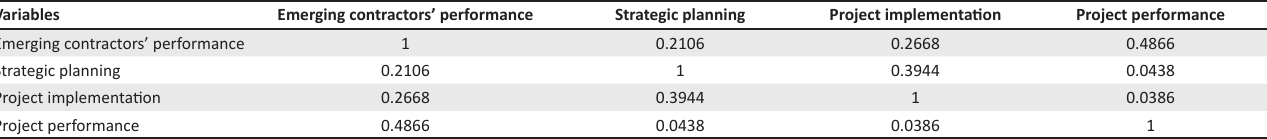
TABLE 4: Correlation analysis: Emerging contractors’ performance, strategic planning, project implementation and project